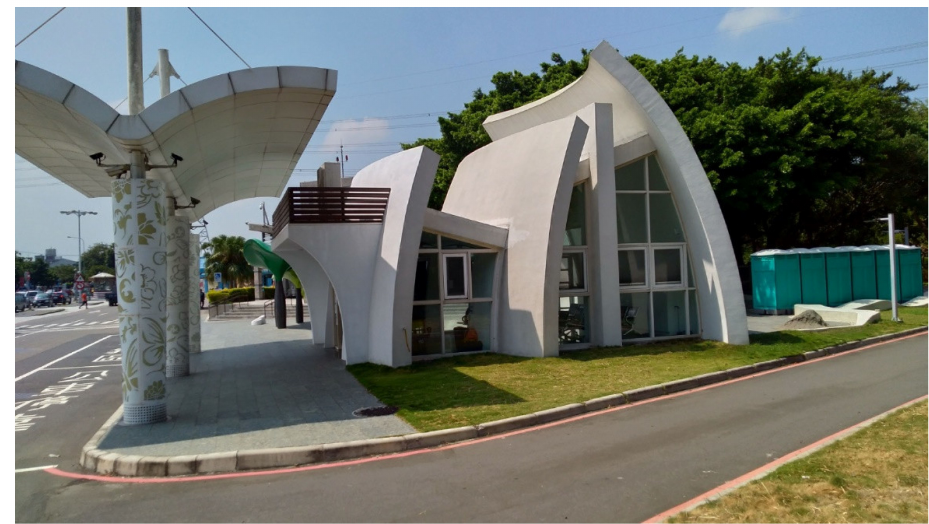
Figure 5. A shelter in Zhongli Service